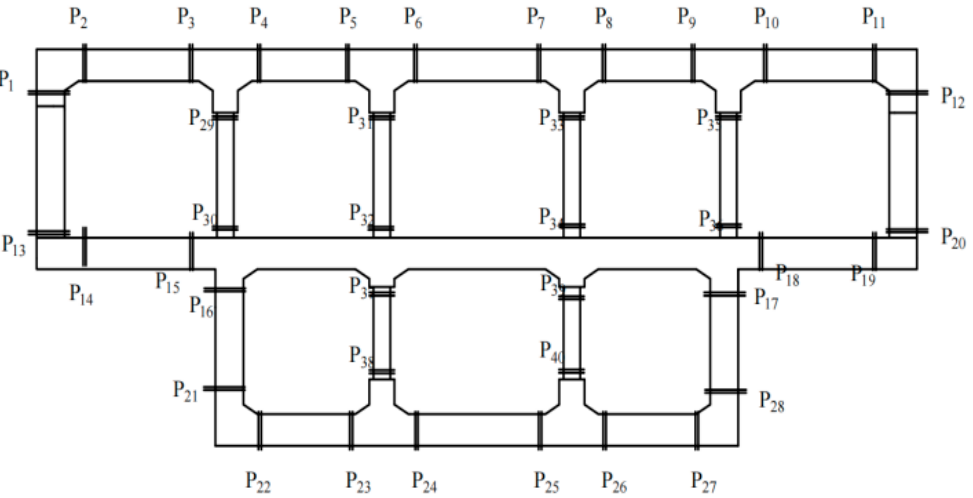
Figure 6. Distribution of feature points of the subway station structure.